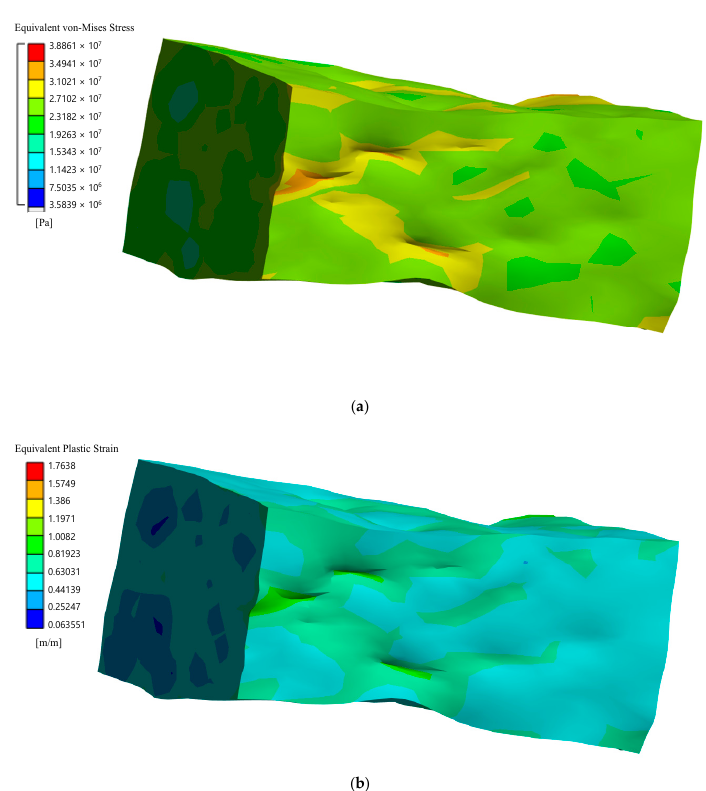
Figure 10. Equivalent von Mises stress, Pa ( a ) and equivalent plastic strain ( b ) with spherical filler at the moment of loss of bearing capacity (first stage). Equivalent von-Mises Stress 3.9664 × 10 7 3.5347 × 10 7